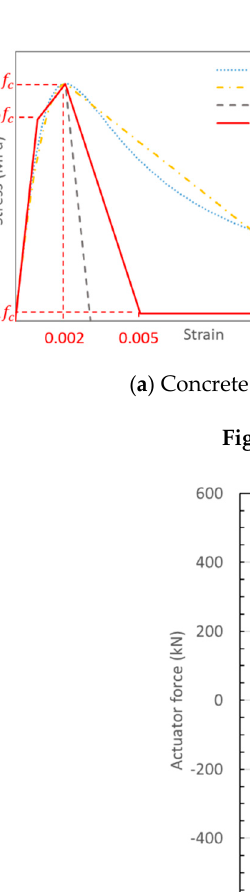
Figure 4. Nonlinear model of concrete and rebar.